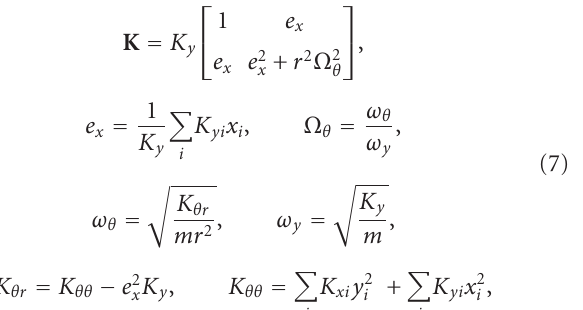
where m represents the lumped mass of the deck; r is the mass radius of gyration about the vertical axis through CM (cid:11) ( a 2 + b 2 ) / 12; where a and b are the which is given by, r = plan dimensions of the